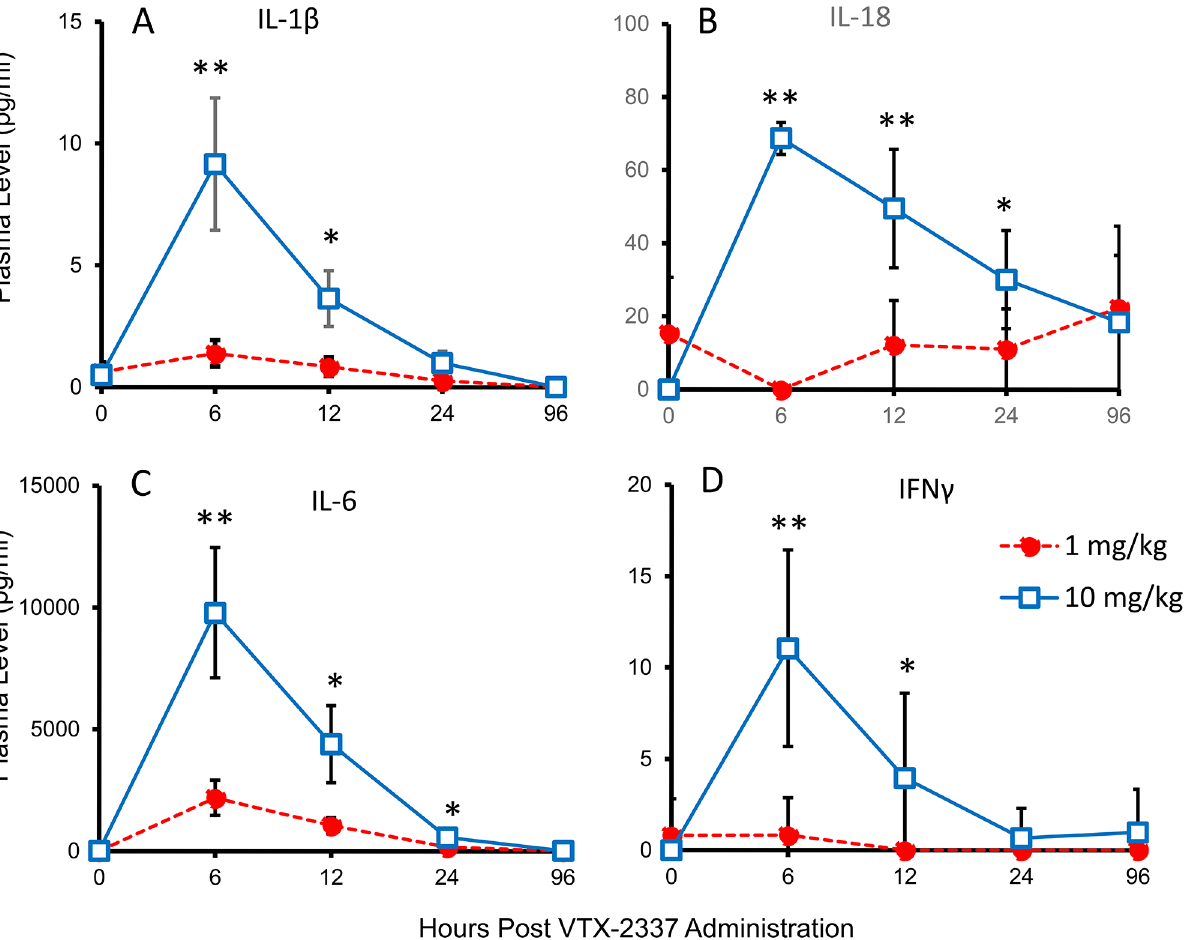
Fig 6. VTX-2337 administration to cynomolgus monkeys induces IL-1 β and IL-18. Male cynomolgus monkeys (n = 6 per group) received a subcutaneously injection of VTX-2337 (1 or 10 mg/kg). Plasma collected predose, and 6, 12, 24 and 96 h following dosing was assessed for levels of IL-1 β , IL-18 and IL-6. Cytokine levels in pg/mL (mean ± sem) at each time point for the two VTX-2337 dose levels are shown. At each VTX-2337 dose level, plasma cytokine levels at 6, 12, 24 and 96 h were compared to predose levels * , p < 0.05, ** , p < 0.01, by